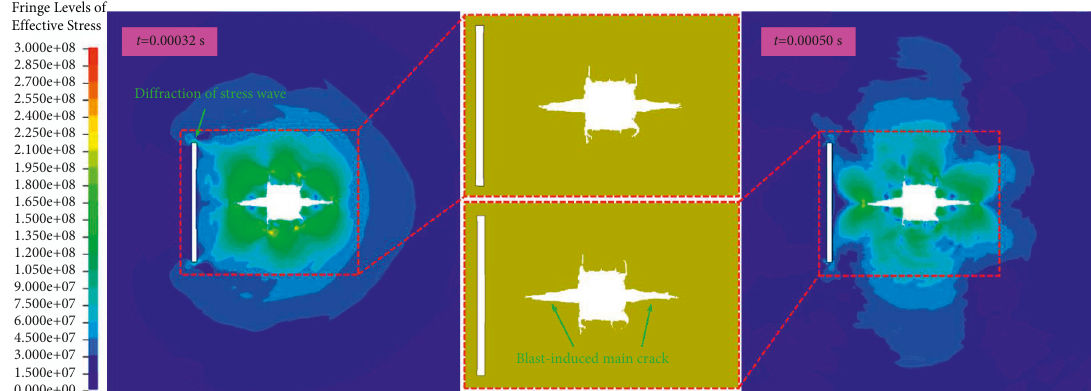
Figure 13: Pressure diagram of explosion stress wave transmission for case CN